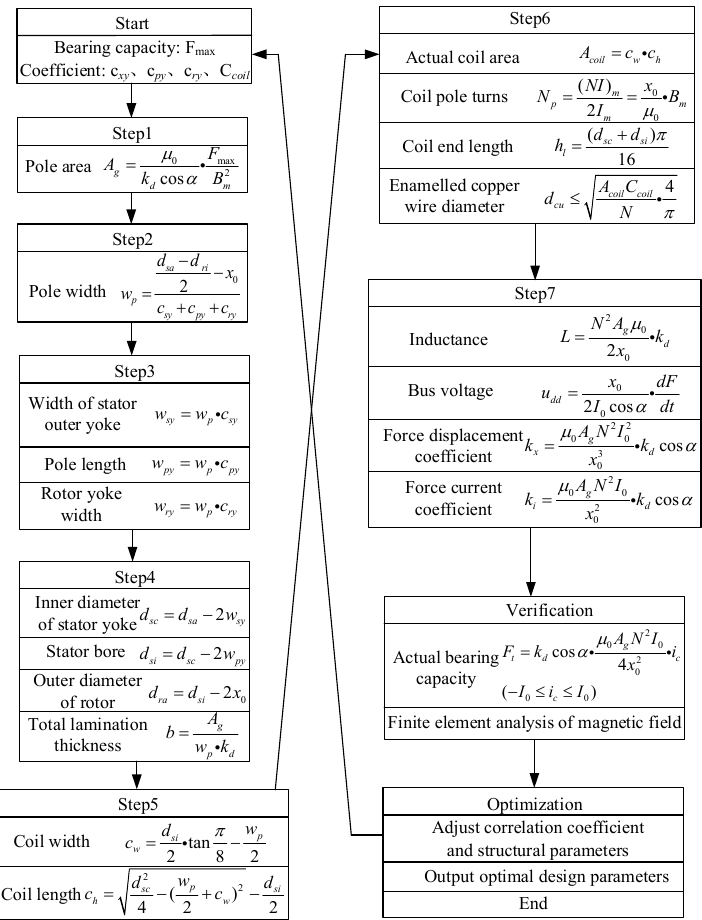
Figure 10. The 8 ‐ pole RMB design process. Figure 10. The 8-pole RMB design process.